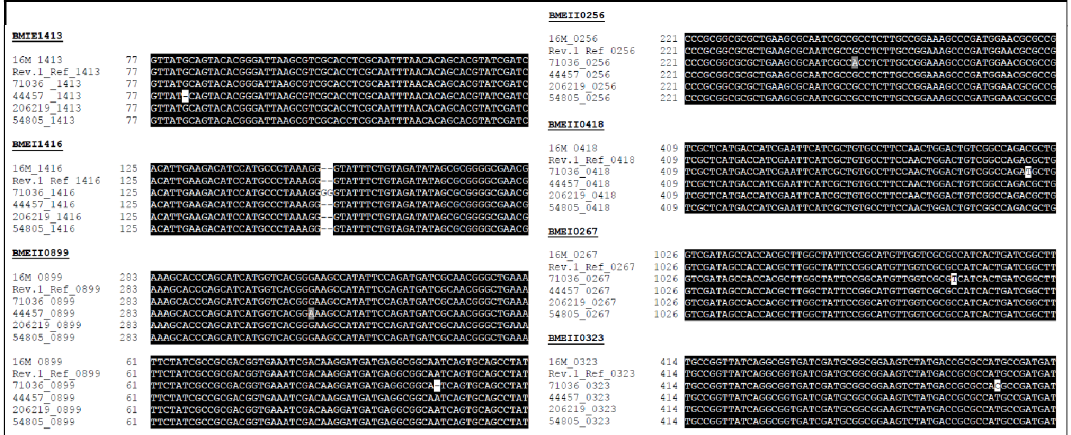
Figure 1. Sanger validation of selected variants. Black color shows conserved regions, gray and white color represent mutant regions.